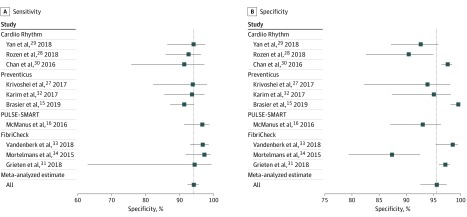
Sensitivity and Specificity for Each Study and the Overall Meta-analyzed Sensitivity and SpecificityBoxes represent the point estimate, and whiskers are 95% CIs. The vertical line indicates the overall meta-analyzed point estimate.